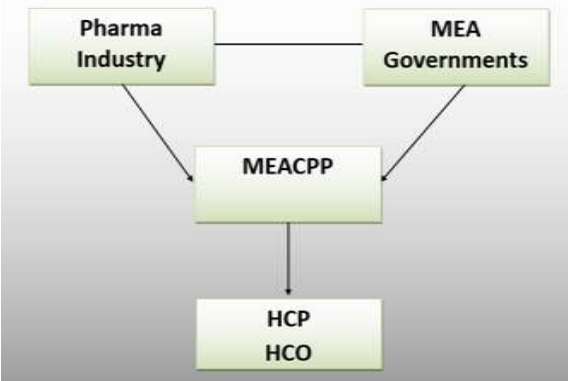
Figure 2. Research Framework.